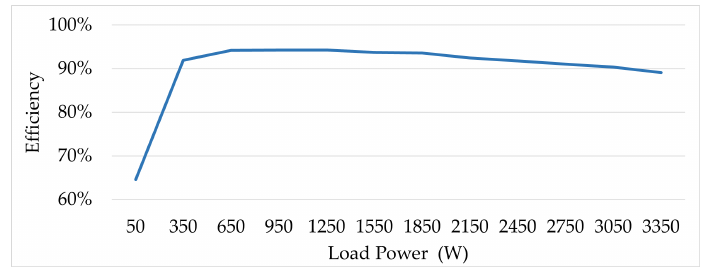
Figure 20. Efficiency versus load for operation mode 2.